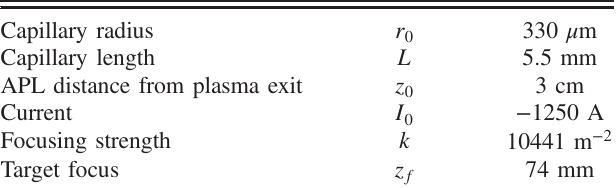
TABLE VII. Simulated APL parameters to give the design bunch parameters in the focus given in Table